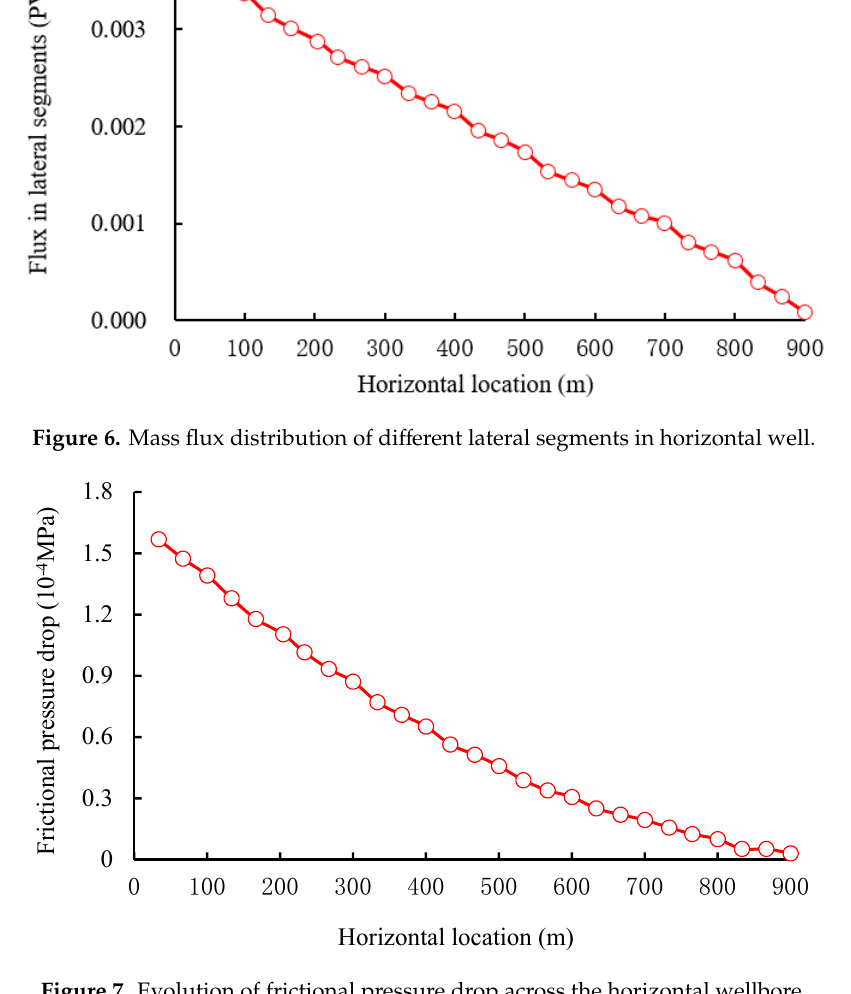
( d ) 1.0 PV Figure 8. Water saturation profiles at different injection pore volume multiples.